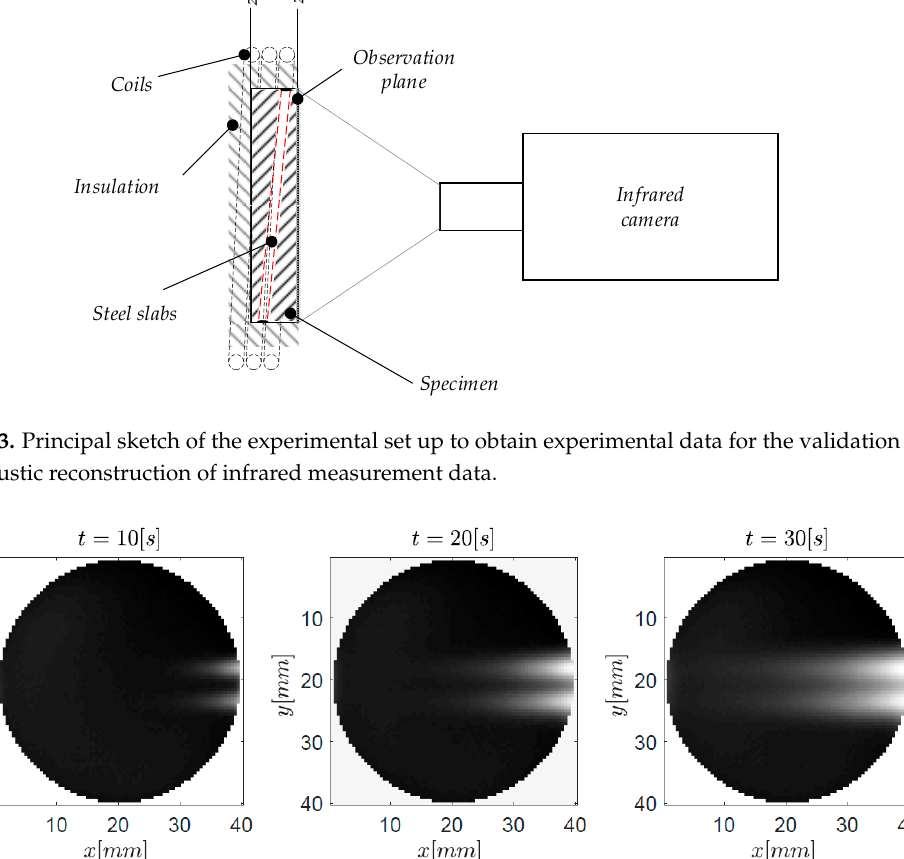
Figure 4. Thermograms at the front surface of the specimen at different time steps ( a ) 10 s, ( b ) 20 s, and ( c ) 30 s based on experimental data collected at the observation plane z = 0.